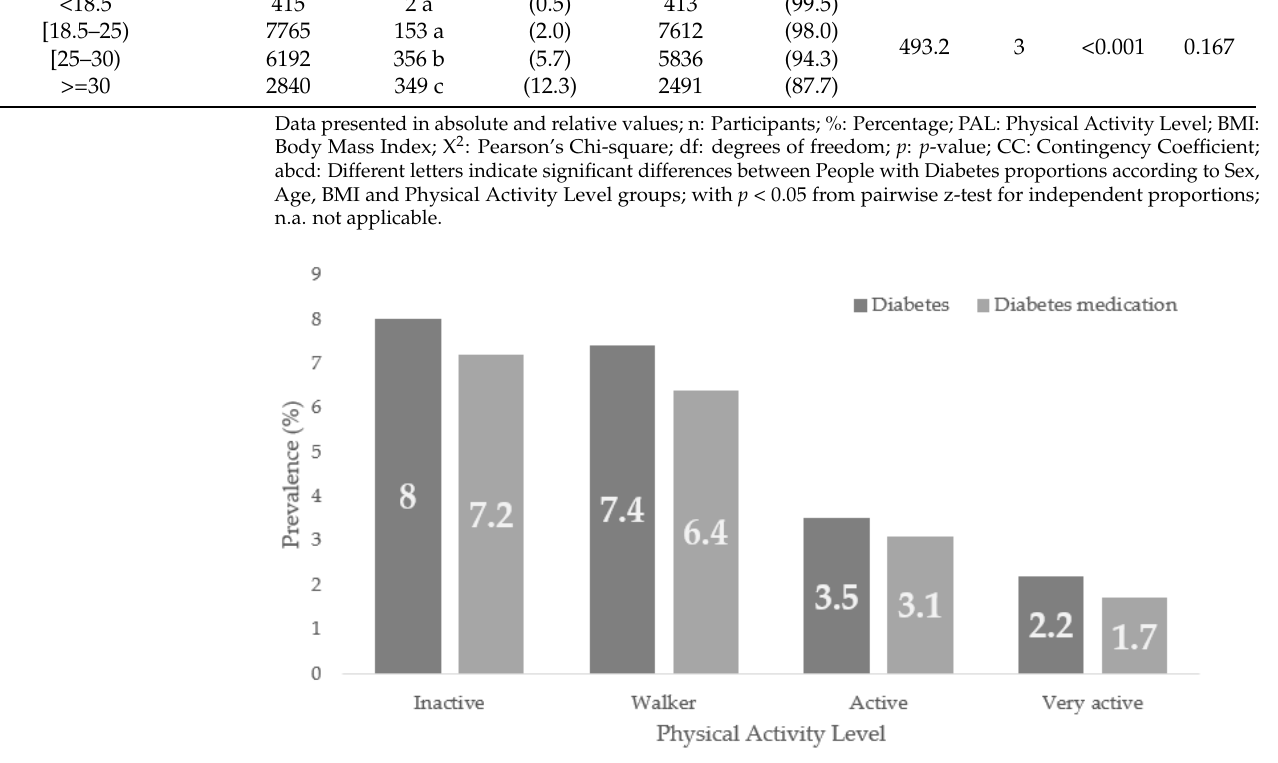
Table 3. Diabetes prevalence through the Physical Activity Level (PAL) according to Sex, Age, and Body Mass Index (BMI).